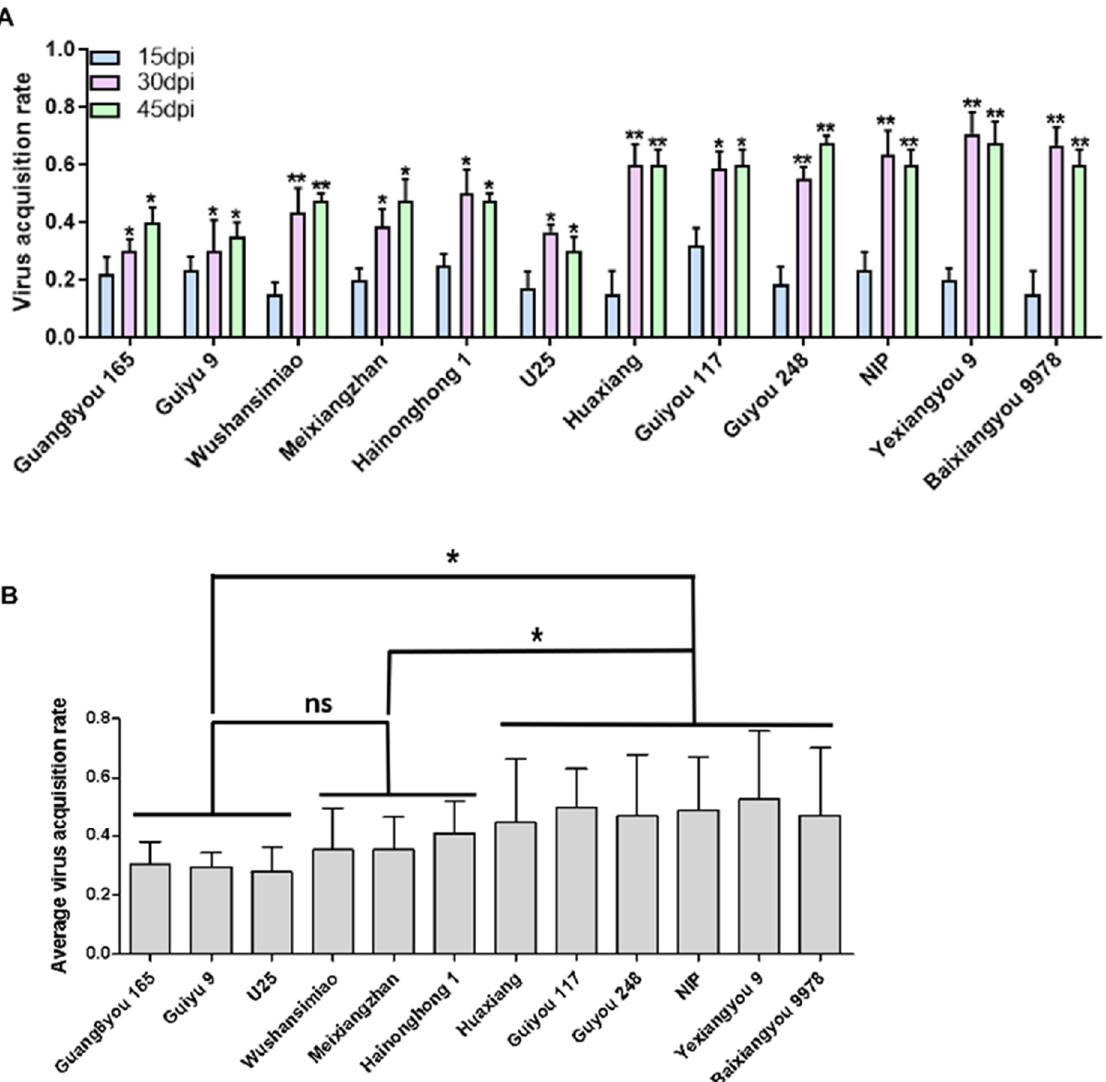
Figure 5. WBPH virus acquisition rates from infected rice plants: ( A ) the rates at which WBPHs acquired SRBSDV from infected rice plants; ( B ) the mean rates of WBPH virus acquisition from infected rice plants at three disease stages. “ns” means no significant difference, “*” means a significant difference ( p < 0.05), “**” means an extremely significant difference ( p < 0.01).